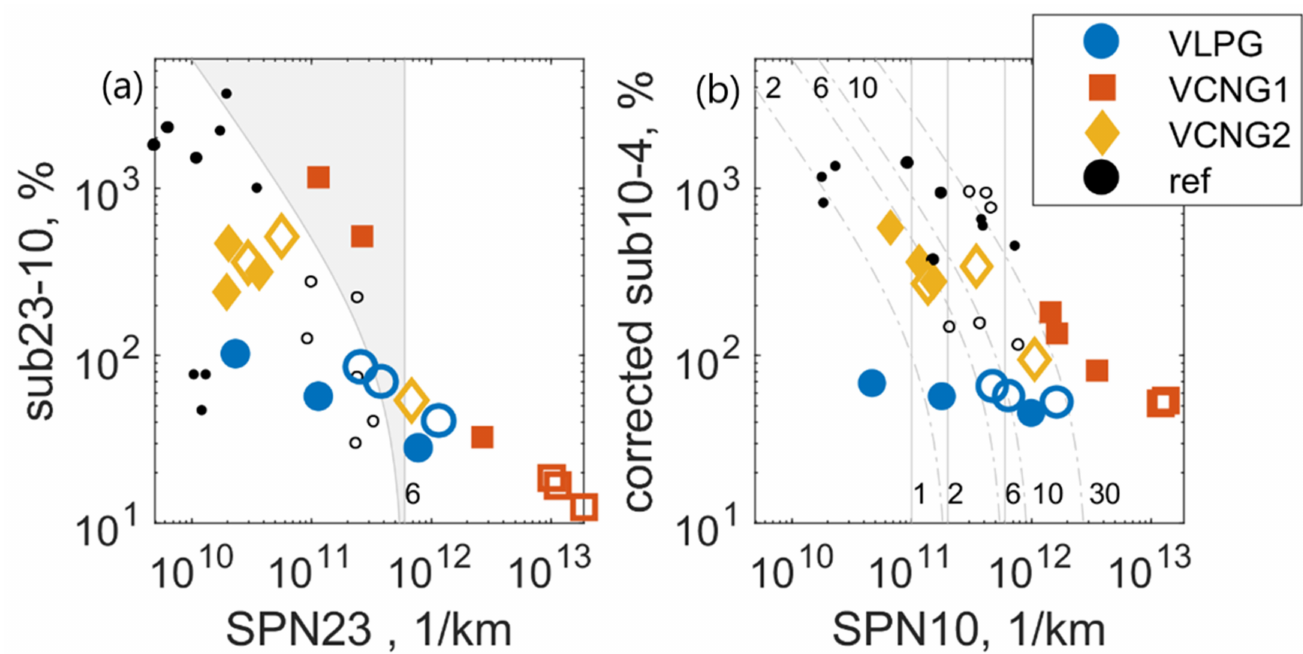
Figure 5. Particle fractions below 23 nm. Data measured with gaseous fuels is presented with filled markers and data for liquid (gasoline) with open markers; ( a ) sub23-10 fraction for uncorrected SPN10 as a function of SPN23. Shaded area marks data for which SPN10 is above limit 6 × 10 11 1/km, while SPN23 is below the limit; ( b ) sub10-4 fraction for corrected SPN4c as a function of SPN10. Grey vertical lines show SPN10 levels and curved, dash-dotted lines SPN4c levels. Labels 1, 2, 6, 10 and 30 refer to emission level multiples of 10 11 1/km. Data labelled ref is acquired from literature [13] and represents in left axes corrected sub23-10 and in right axes corrected sub10-2.5 levels instead of